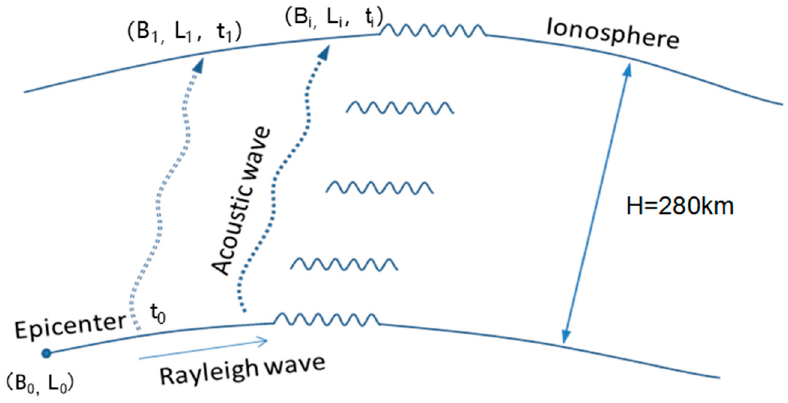
Figure 6. The diagram of disturbances propagation.